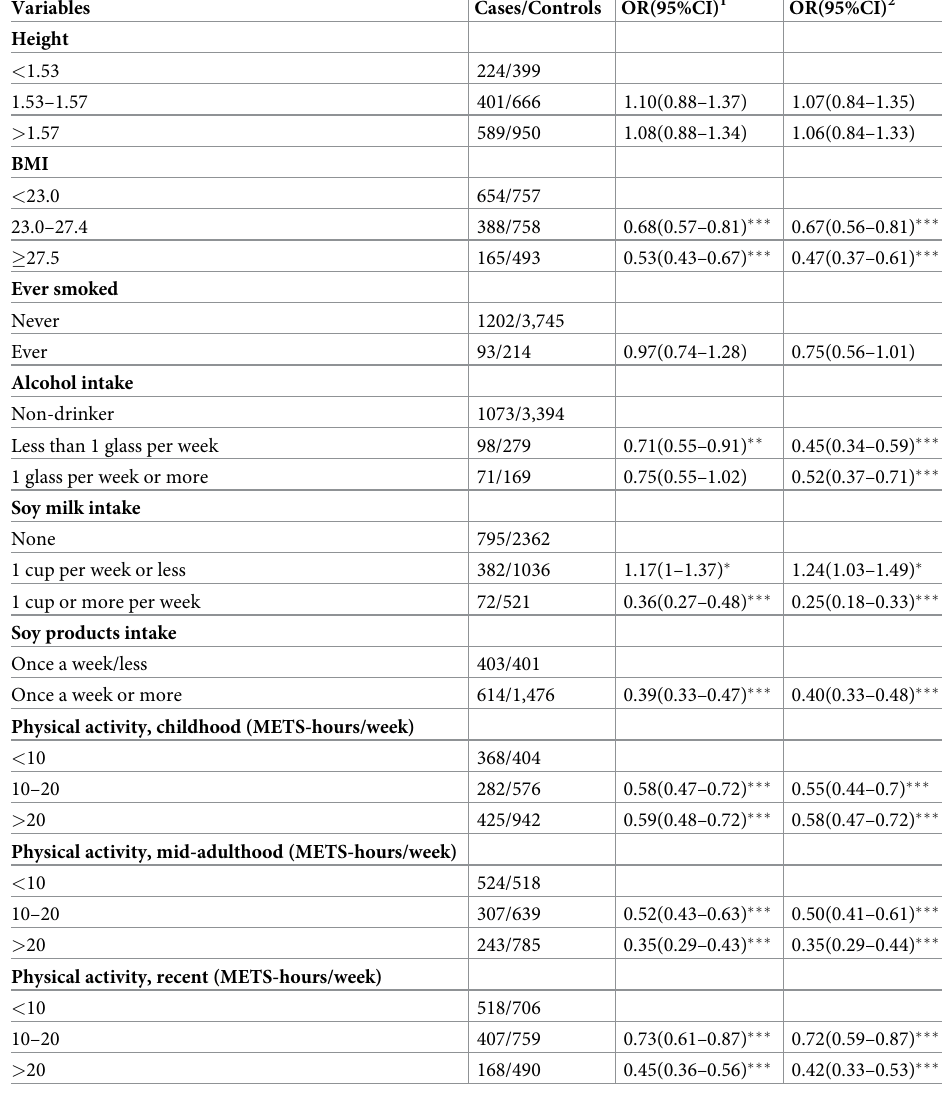
Table 3. Anthropometric and lifestyle factors and their association with breast cancer.